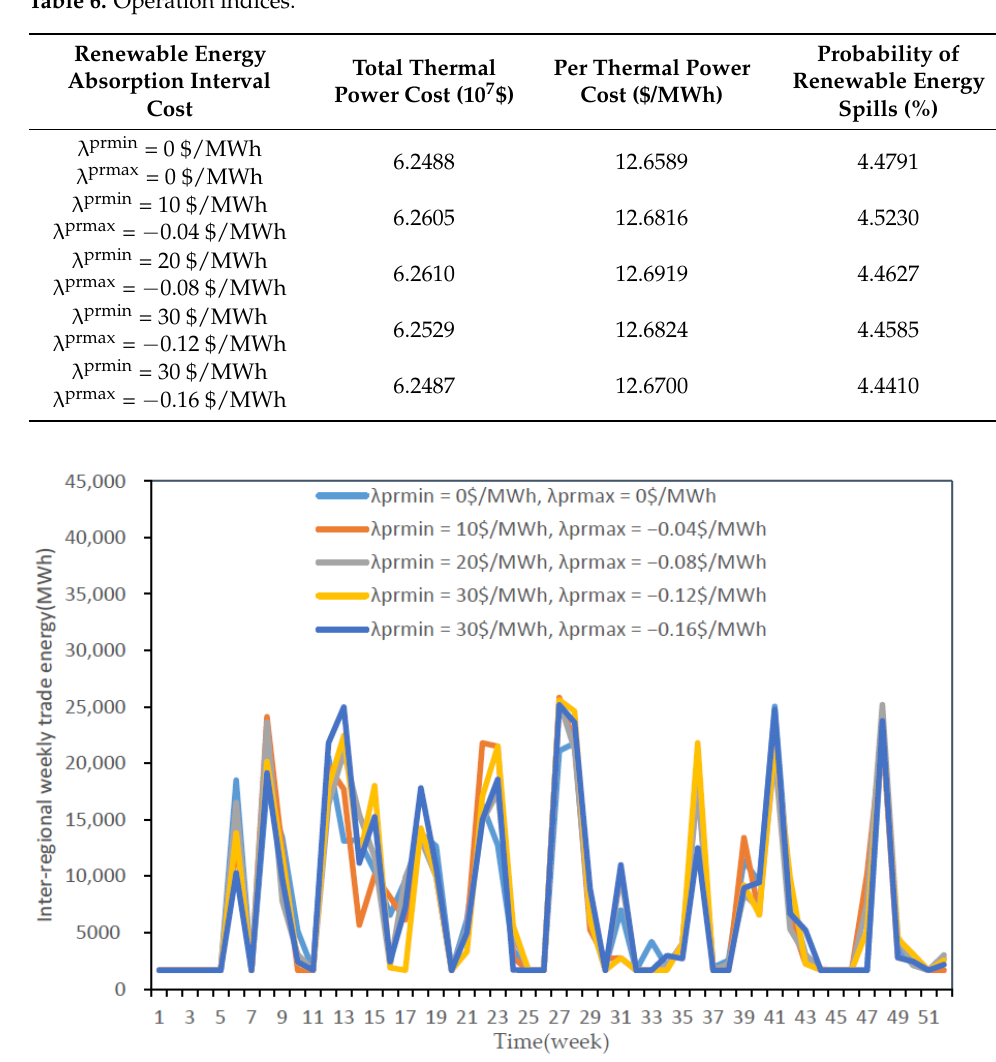
Figure 6. Cross-regional weekly trade energy.